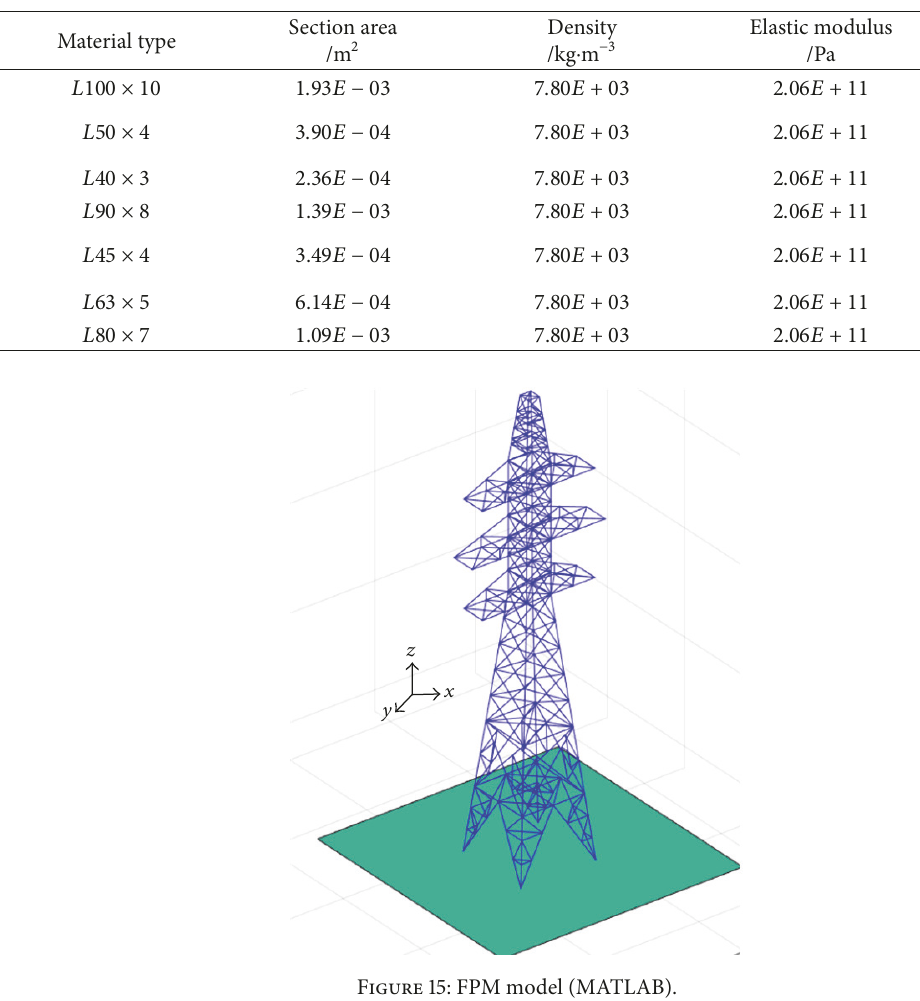
Table 1: Material parameters of transmission tower.